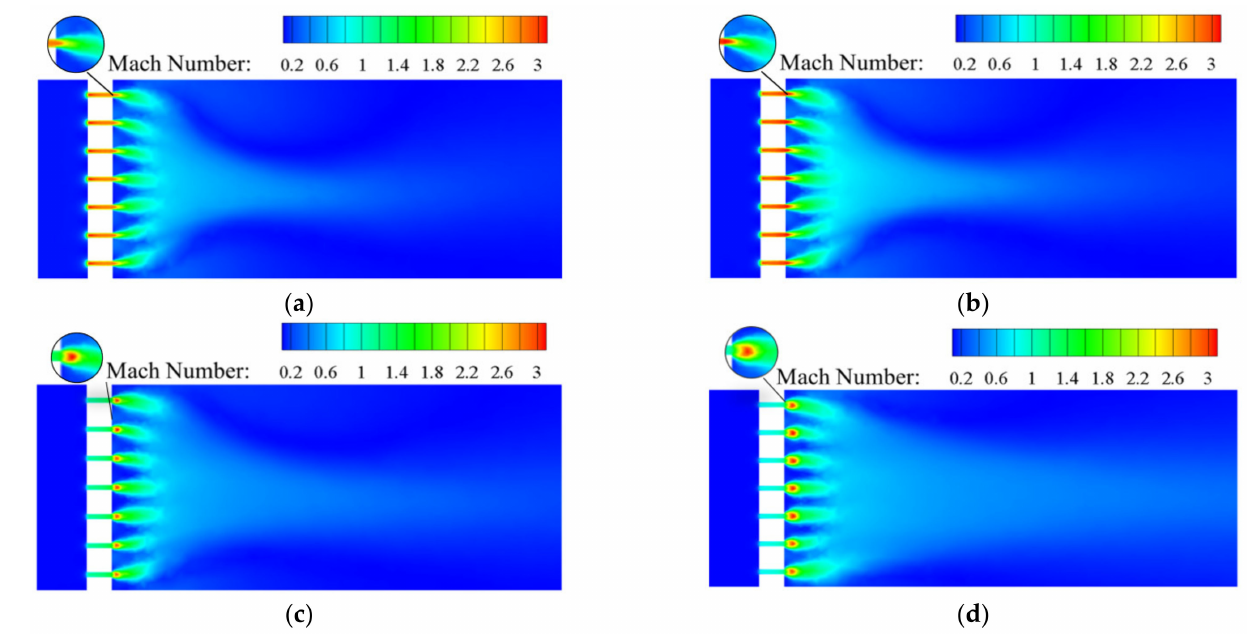
Figure 9. Mach number distribution on the symmetry plane for the conventional orifice plate structure under different mass flow rates. ( a ) Q m = 0.02 kg s − 1 . ( b ) Q m = 0.1 kg s − 1 . ( c ) Q m = 0.5 kg s − 1 . ( d ) Q m = 1 kg s − 1